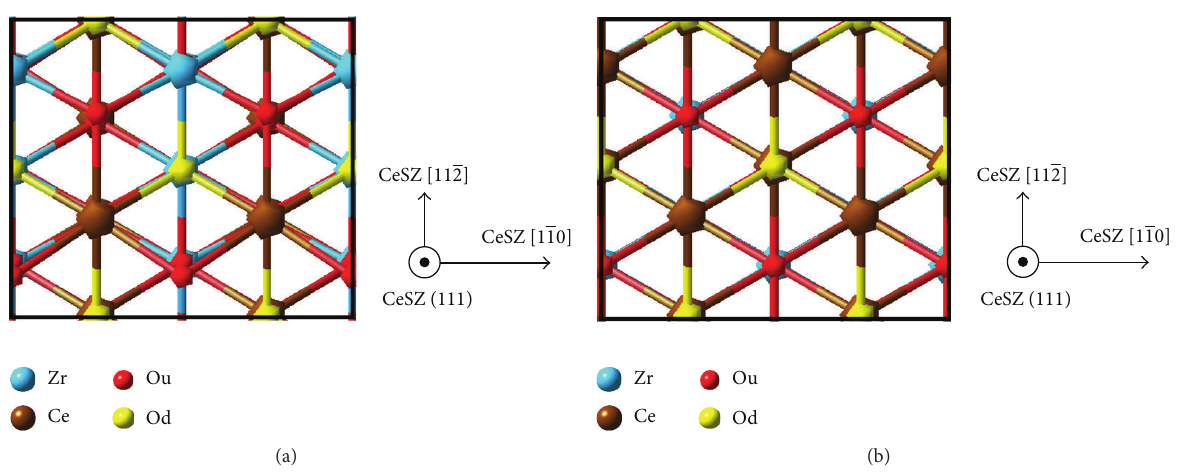
Figure 3: Schematic illustration of the adsorption sites for (a) Ce-segregation-free and (b) Ce-segregated CeSZ (111) surfaces.